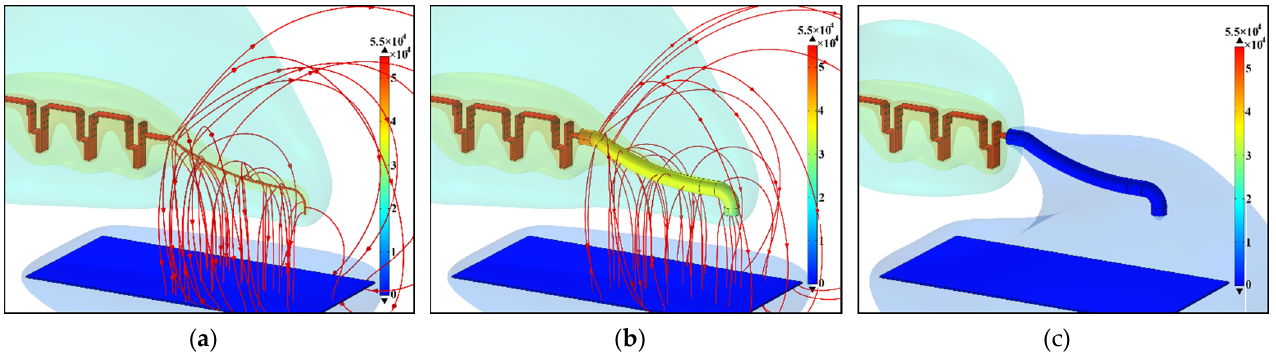
Figure 8. The effect of shielding the test cable: ( a ) initial state of the test cable; ( b ) test cable passed through an aluminum tube; ( c ) test cable passed through a grounded aluminum tube.